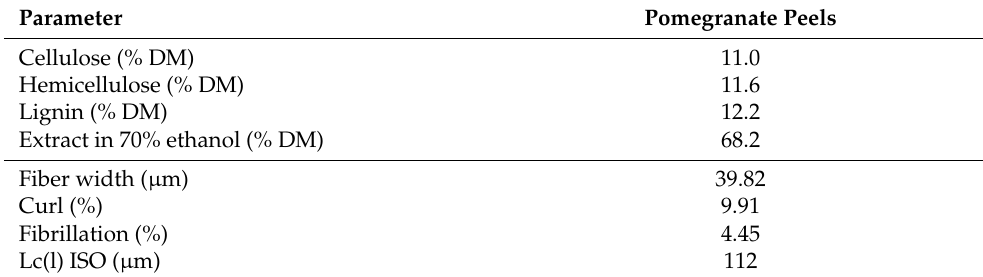
Table 9. Composition of natural fibers in pomegranate peels and mechanical and optical characteris- tics of the isolated fibers.